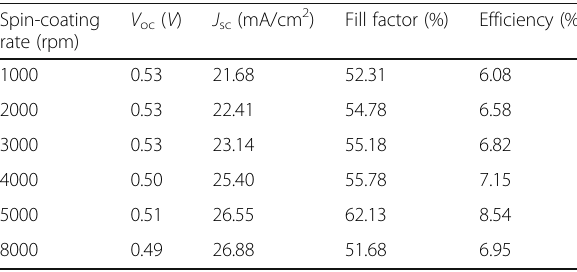
Table 1 J-V characterization of the textured HHSCs with different PEDOT:PSS coating rates from 1000 to 5000 rpm and 8000 rpm at